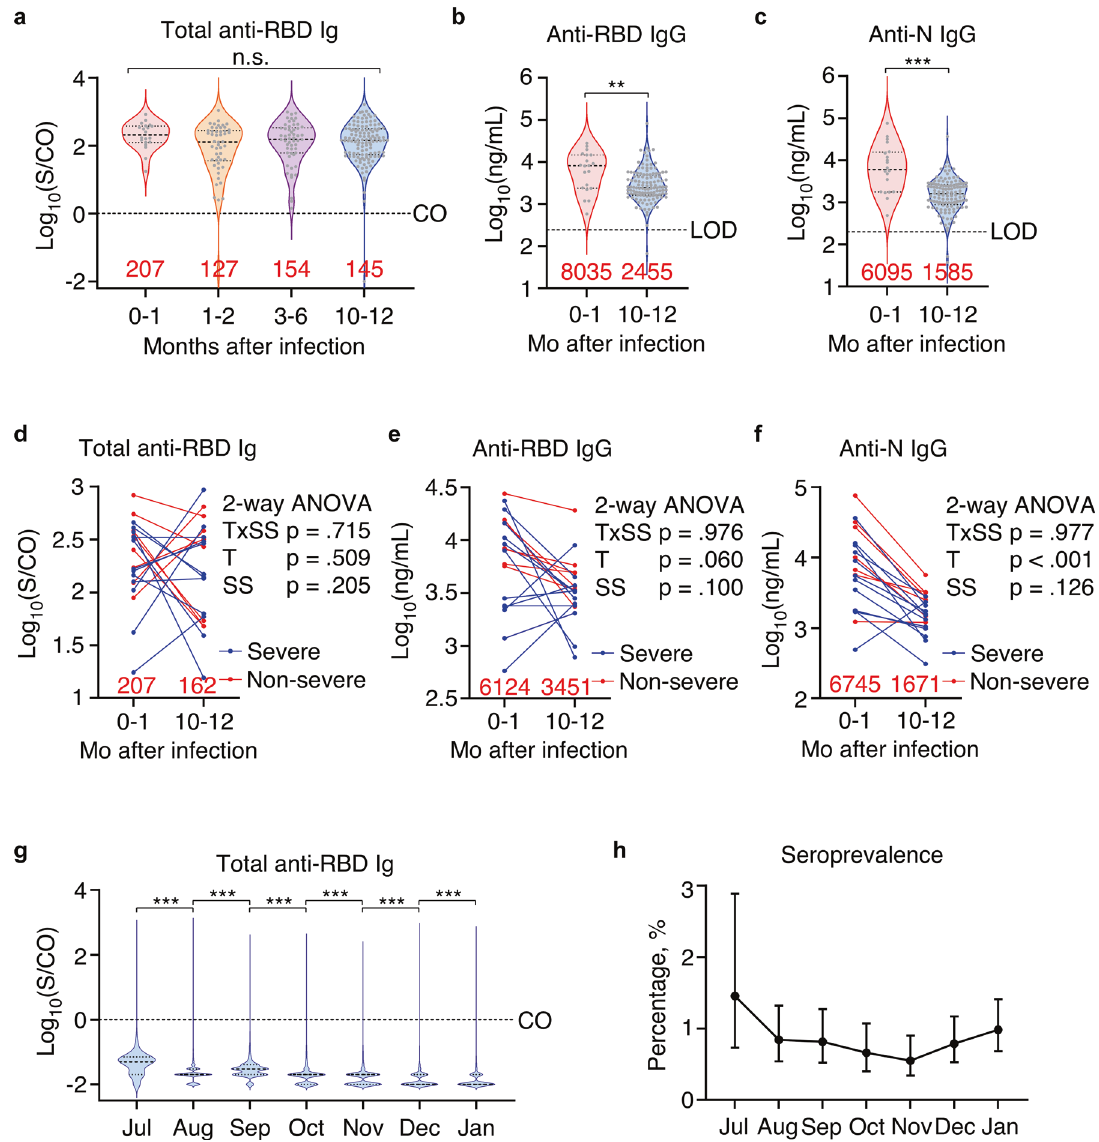
Fig. 2 Decay of antibody response in COVID-19 patients and general population. a Total anti-RBD antibodies in 0 – 1-month post-infection ( n = 20), 1 – 2-month post-infection ( n = 50), 3 – 6-month post-infection ( n = 54), and 10 – 12-month post-infection sera ( n = 121) measured by CMIA. b , c Anti-RBD ( b ) and anti-N IgG ( c ) concentrations in 0 – 1-month post-infection ( n = 20) and 10 – 12-month post-infection sera ( n = 121). d – f Before-after plots of total anti-RBD antibodies ( d ), anti-RBD ( e ) and anti-N IgG ( f ) concentrations in 0 – 1-month post-infection and 10 – 12-month post-infection sera from the sample patients. Data were analyzed by matched two-way ANOVA and p values for time effect (T), disease severity scale (SS), and their interactions (TxSS) were reported on the side. n = 20. g Monthly results of total anti-RBD antibodies in patients without COVID-19 history and admitted to Xiangyang Central Hospital. n = 550 (Jul), 2258 (Aug), 2333 (Sep), 2426 (Oct), 2912 (Nov), 3052 (Dec) and 2953 (Jan 2021). h Monthly seroprevalence with 95% CI based on CMIA results in patients admitted to Xiangyang Central Hospital. Red numbers indicate median value for violin plots. Dotted lines indicate the diagnostic cut-off (CO) for total anti-RBD antibody titers or the limit of detection (LOD) for anti-RBD or anti-N IgG concentrations. ** p < .01, *** p < .001, n.s. not signi fi